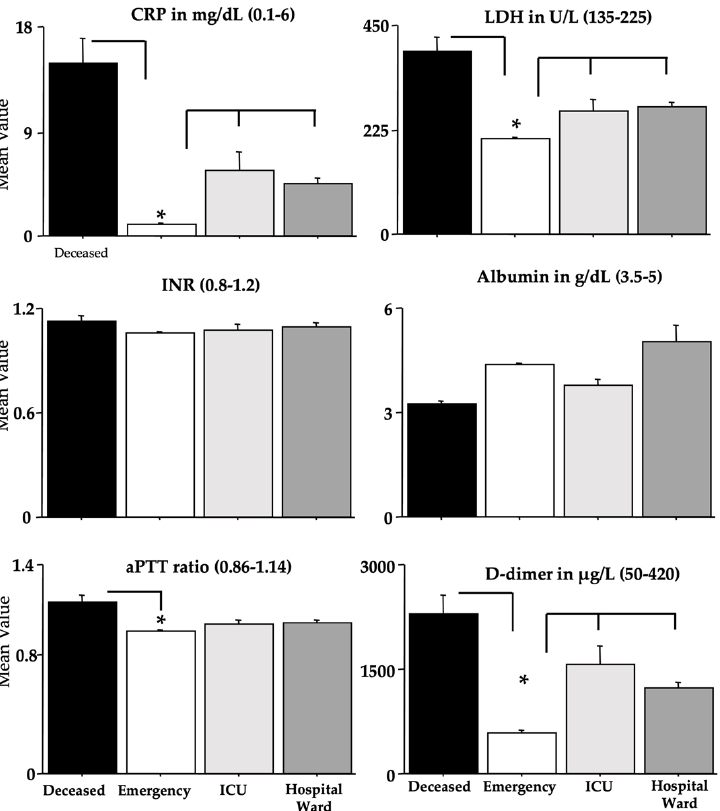
Figure 5. CRP, LDH, INR, albumin, aPTT, and D ‐ dimer in recruited individuals (and relative refer ‐ ence ranges). The error bars indicate the pooled standard error means (SEM) derived from the ap ‐ propriate error mean square in the ANOVA. The asterisks (* p < 0.05) indicate post hoc differences between groups.